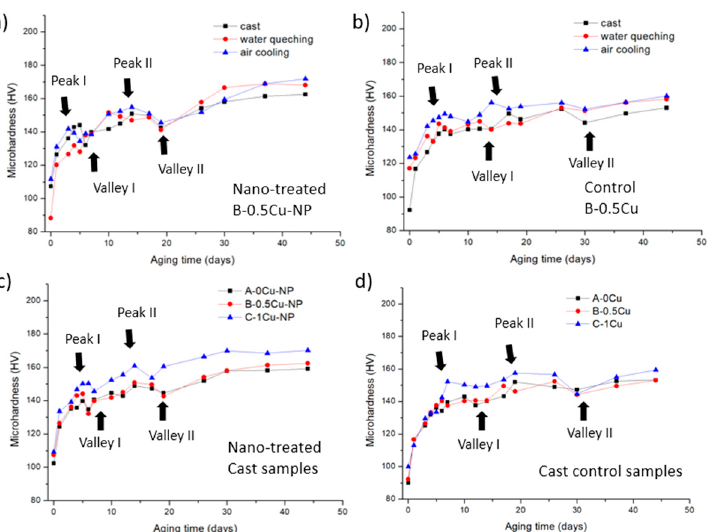
Figure 4. ( a ) B-0.5Cu-NP and ( b ) B-0.5Cu sample’s hardness during natural aging after casting, water quenching, and air cooling; ( c ) nano-treated samples and ( d ) control samples’ hardness during natural aging after cast. Peak I indicates the clustering of solute at-oms; Peak II indicates the formation of GPI; Valley I indicates the transition from clustering to GPI zones; Valley II indicates the transition from GPI zones to GPII zones